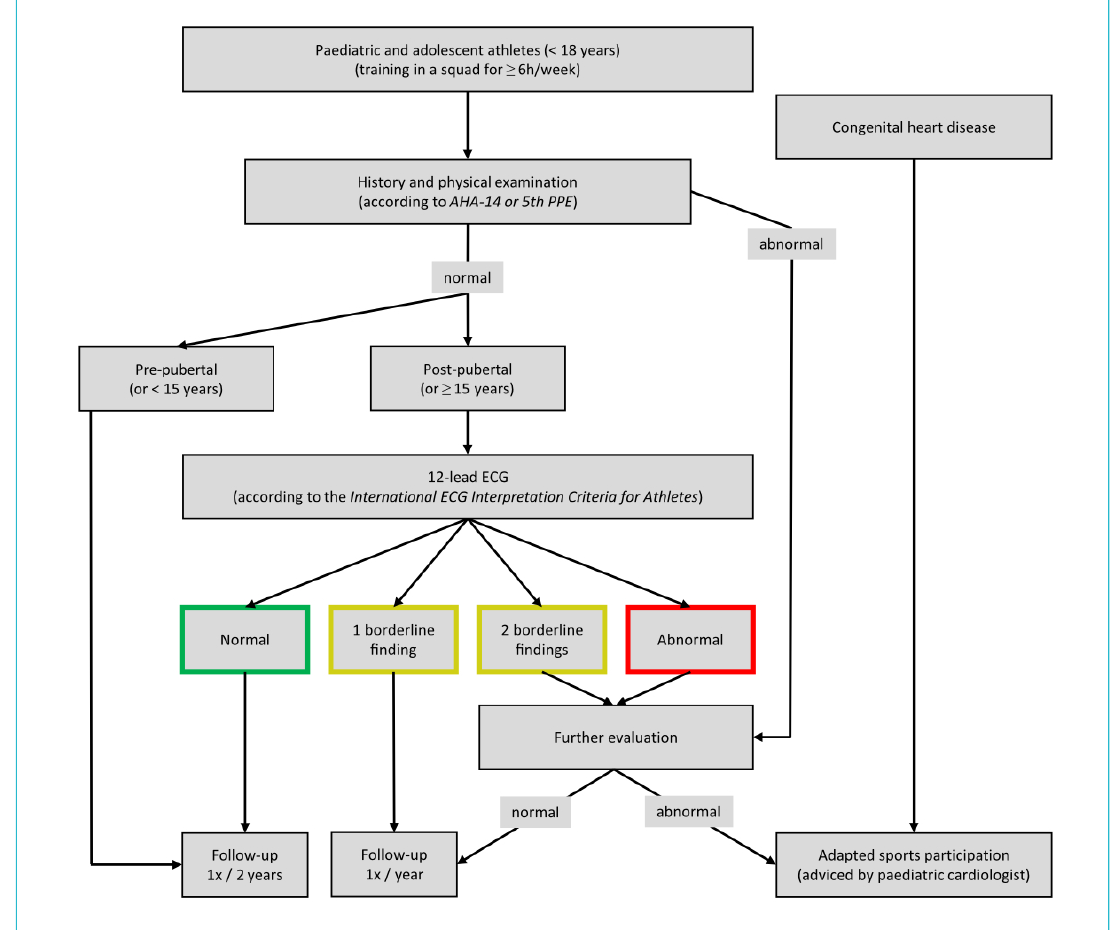
Figure 2: Preparticipation cardiovascular evaluation and follow-up algorithm for paediatric and adolescent athletes in